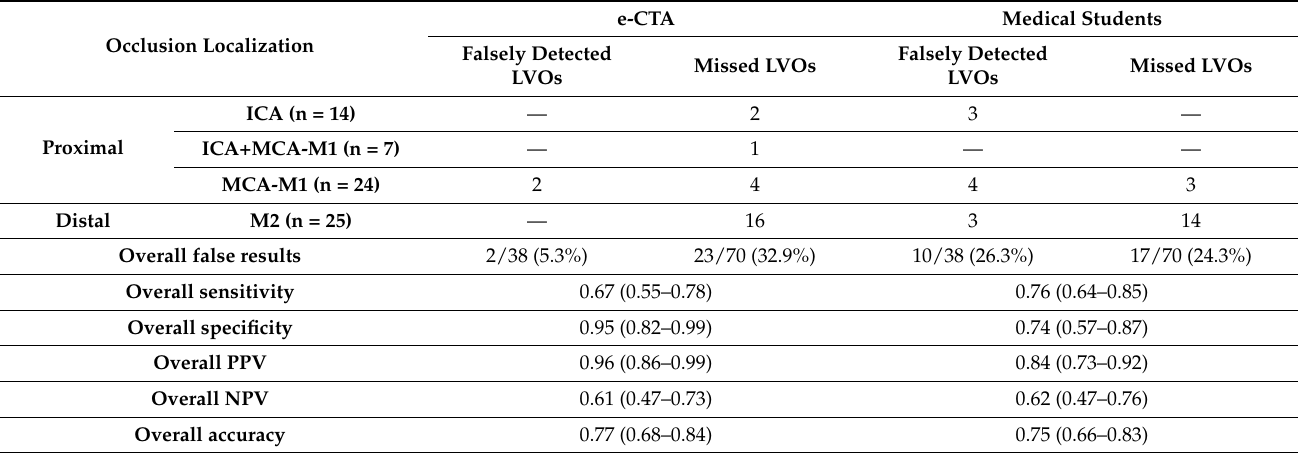
Table 2. Distribution of proximal, distal, and overall LVOs falsely detected and missed by e-CTA and medical students with overall sensitivity, specificity, PPV, NPV, and accuracy. Occlusion